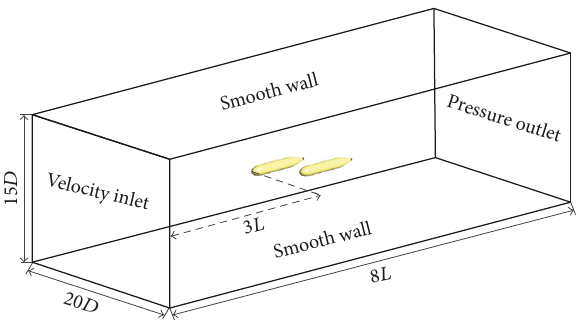
Figure 4: Computational domain and boundary conditions.